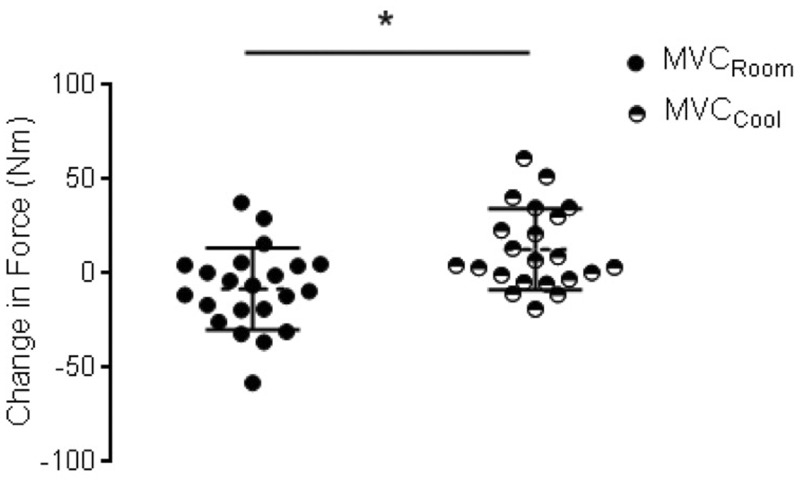
Temperature effects on maximal voluntary contraction (MVC). Change in MVC torque in room (black) and cool (black/white) collapsed across exercise modalities. *Indicates a significant (p<0.05) main effect of temperature condition.